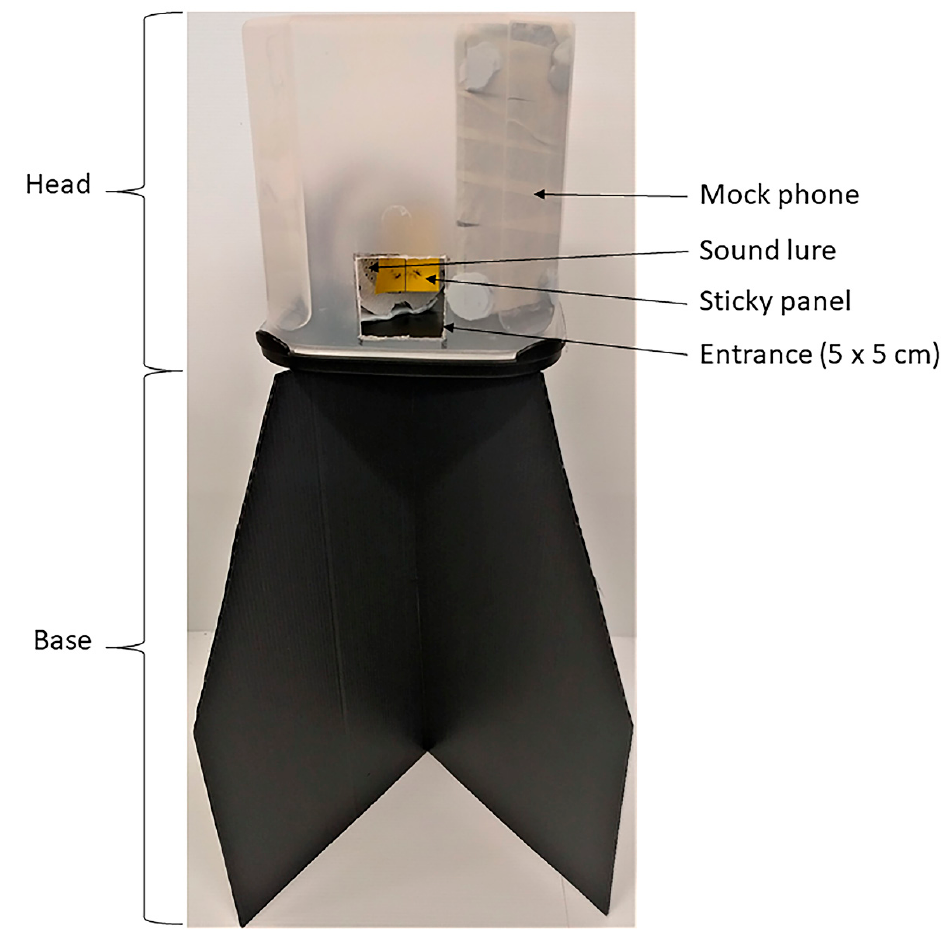
Figure 1. Basic general design of the main prototype MAST (MAST 1) used in developmental trials.